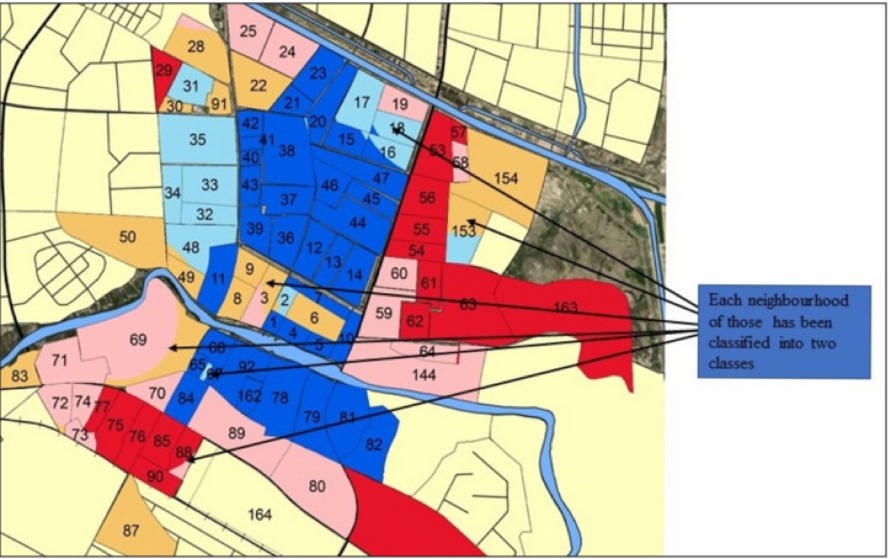
Figure 15. Zoomed-in final map, showing the effects of continuous factors on the classification of several neighbourhoods; each neighbourhood has been classified into two